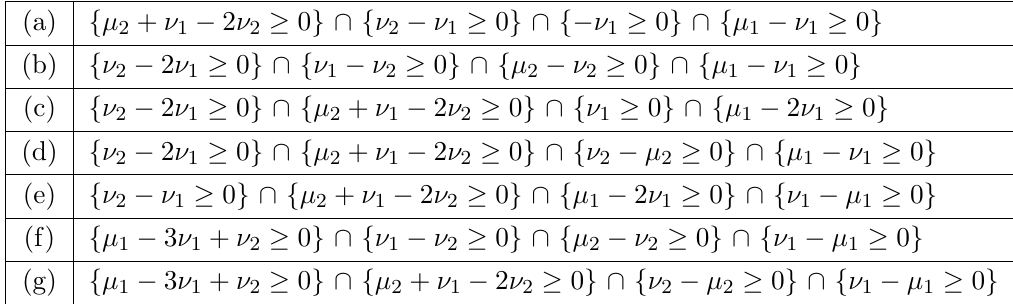
Table 3 . Geometric inequalities (\Nef conditions") de(cid:12)ning the K(cid:127)ahler chambers of the 7 resolu- tions of the E 22 ; 3 2